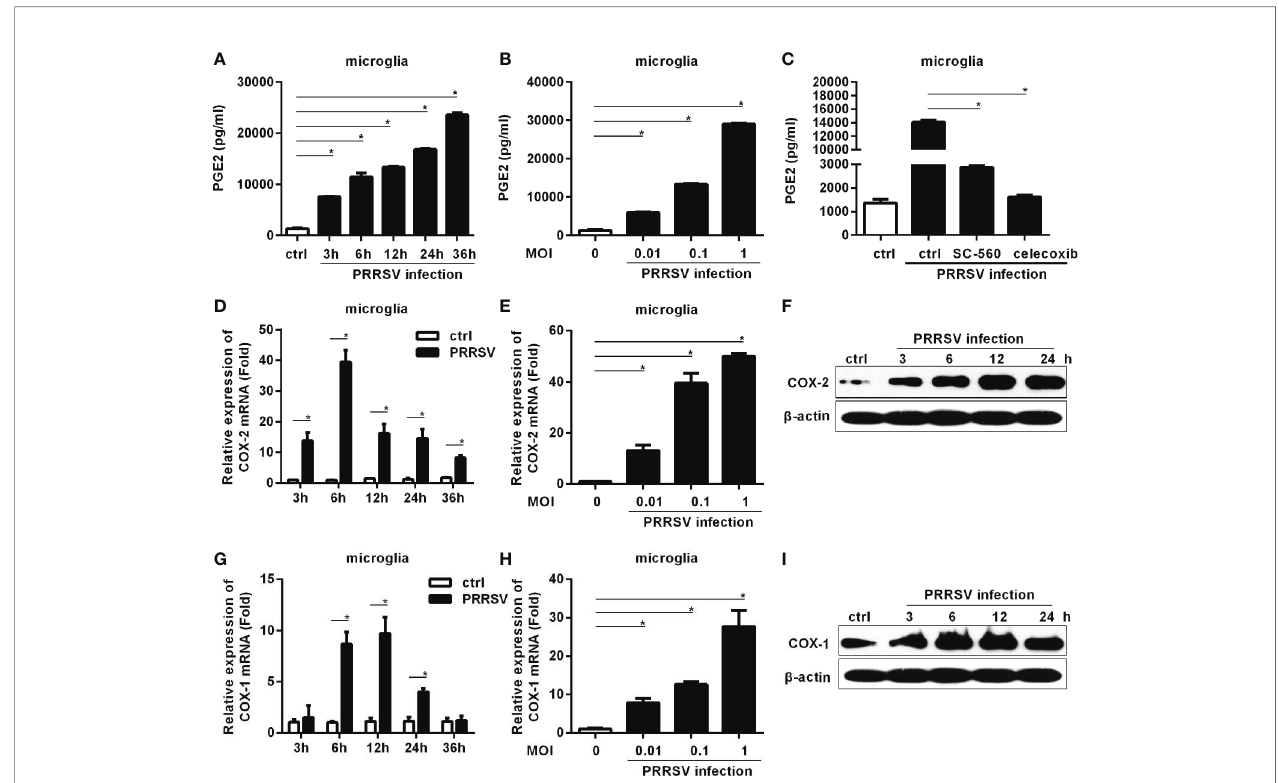
FIGURE 1 | COXs and PGE2 are induced by HP-PRRSV infection in microglia. (A) Microglia were infected with medium alone, or HP-PRRSV strain HV (MOI, 0.1). Supernatants were harvested at 3, 6, 12, 24, and 36 hours post-infection, and PGE2 in supernatants (pg/mL) was determined by ELISA. (B) Microglia were infected with HV at an MOI of 0.01, 0.1, or 1. Supernatants were harvested at 6 hours post-infection, and PGE2 in supernatants (pg/mL) was determined by ELISA. (C) Microglia were pretreated with DMSO, COX-1 inhibitor sc-560 (1 m M), or COX-2 inhibitor celecoxib (1 m M) for 1 hour, and then mock-infected or infected with HV at an MOI of 0.1. At 12 hours post-infection, supernatants were harvested for PGE2 analysis using ELISA. (D) Microglia were inoculated with medium alone, or HP-PRRSV strain HV at an MOI of 0.1. COX-2 expression was analyzed using real-time PCR at 3, 6, 12, 24, and 36 hours post-inoculation. Results were normalized to GAPDH and expressed as fold induction over medium alone. (E) Microglia were infected with HP-PRRSV strain HV at an MOI of 0.01, 0.1, or 1, and total RNAs were extracted from cell lysates at 6 hours post-infection. COX-2 mRNA level was quanti fi ed by real-time PCR. (F) COX-2 protein levels in microglia infected with HP-PRRSV strain HV (MOI, 0.1) were analyzed using Western-blot at 3, 6, 12, and 24 hours post-inoculation. b -actin was set up as a loading control. (G) COX-1 mRNA level in microglia infected with HP-PRRSV strain HV (MOI, 0.1) was quanti fi ed by real-time PCR at 3, 6, 12, 24, and 36 hours post-infection. (H) HP-PRRSV strain HV infected microglia at an MOI of 0.01, 0.1, 1, and COX-1 mRNA level was quanti fi ed by real-time PCR at 12 hours post-infection. (I) COX-1 protein levels in microglia infected with HV (MOI, 0.1) were assessed by Western-blot at 3, 6, 12, and 24 hours post-infection. Data are representative of three independent experiments (mean ± SEM). Statistical analysis was performed by Student ’ s t -test. *, P < 0.05